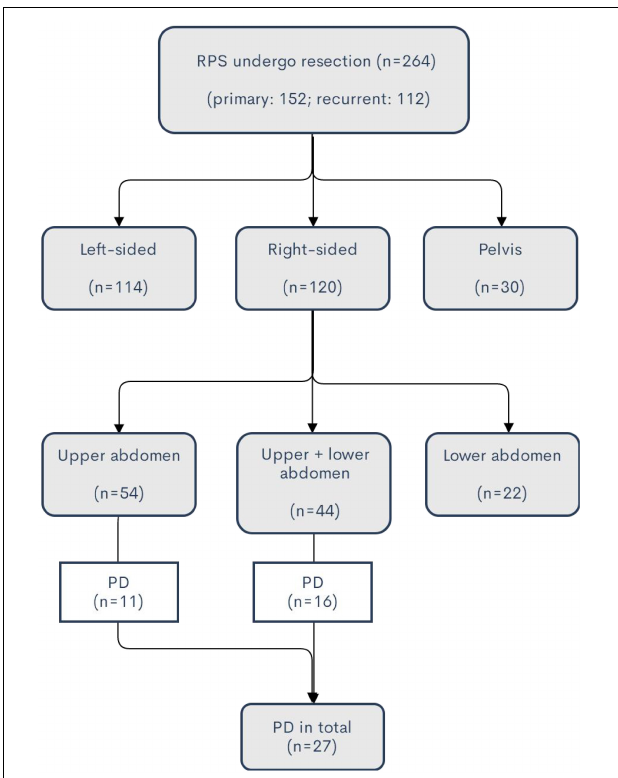
FIGURE 1 | Summary of tumor locations of the patients in the study. For the huge tumor exceeding the midline or multifocal disease, the side of location is defined as the major part of the tumor